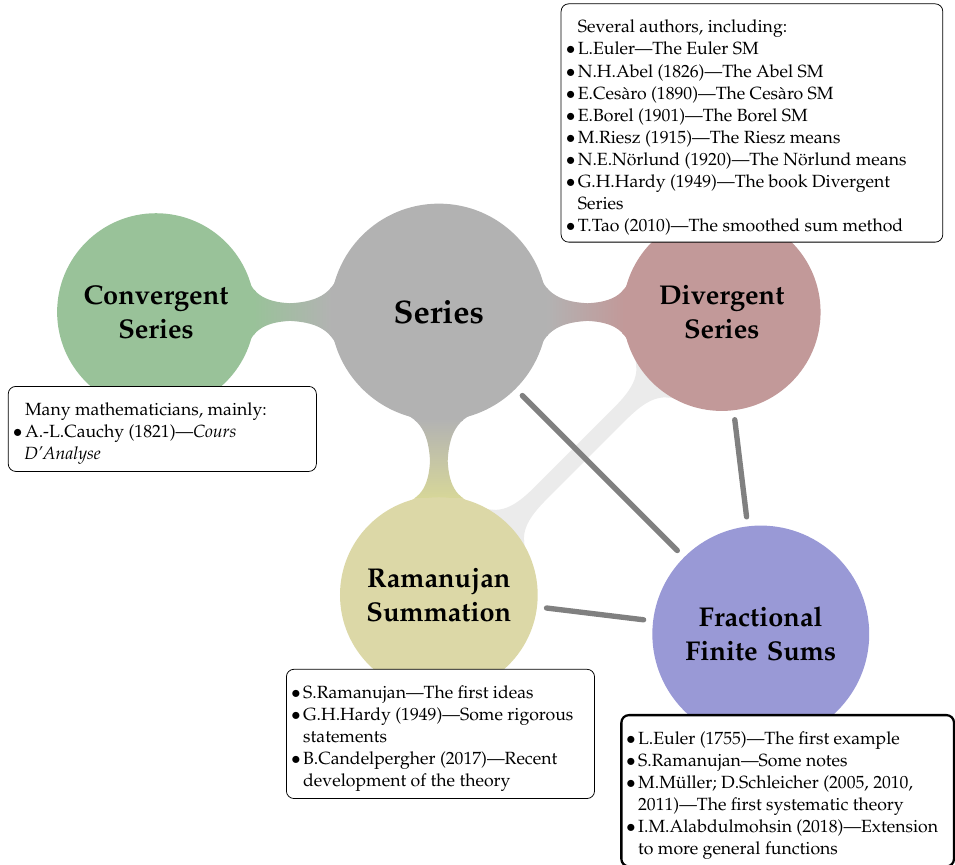
Figure 1. Mind map of the structure. Lists of the main contributors/year of